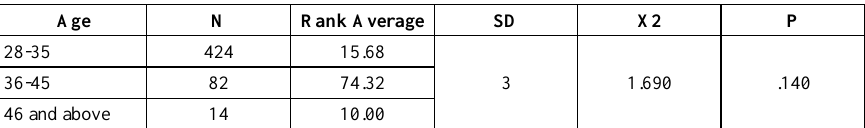
Table 8. Distance education status by age